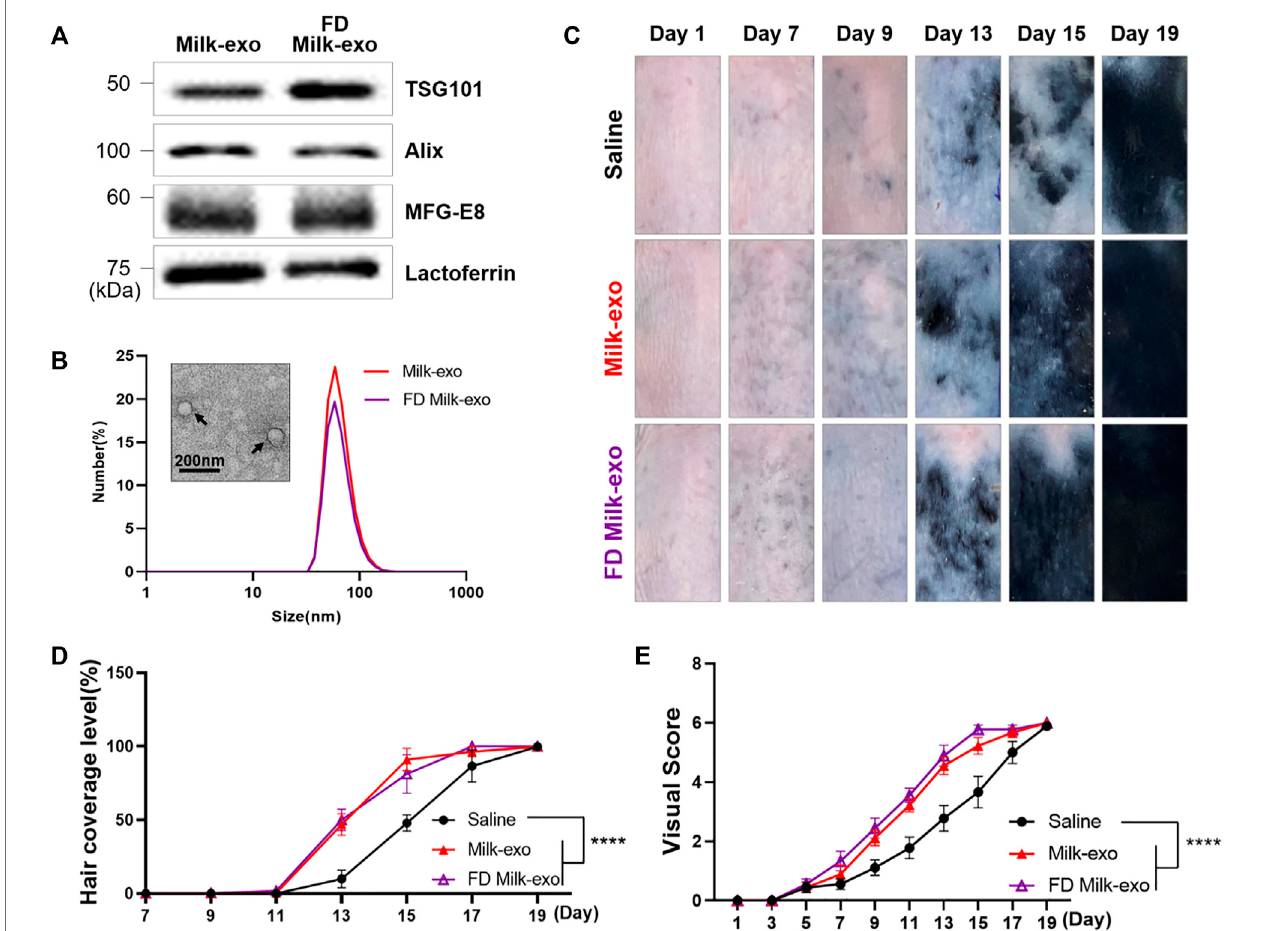
FIGURE8| CharacterizationoflyophilizedMilk-exoandconservationof invivo hairgrowthability. (A) Westernblotanalysisofexosomemarkers(TSG101,Alix)and milk speci fi c proteins (MFG-E8 and lactoferrin). (B) Representative TEM image and size distribution diagram of lyophilized Milk-exo. (C) Representative images of hair regenerationafterintradermalinjectionofsaline,Milk-exoandFDMilk-exo. (D) Quanti fi cationofhaircoveragelevel( n =3,**** p < 0.0001versussaline,two-wayANOVA, Dunnett ’ s multiple comparisons test). (E) Mean visual score measurements ( n = 3; **** p < 0.0001, two-way ANOVA, Dunnett ’ s multiple comparisons test).